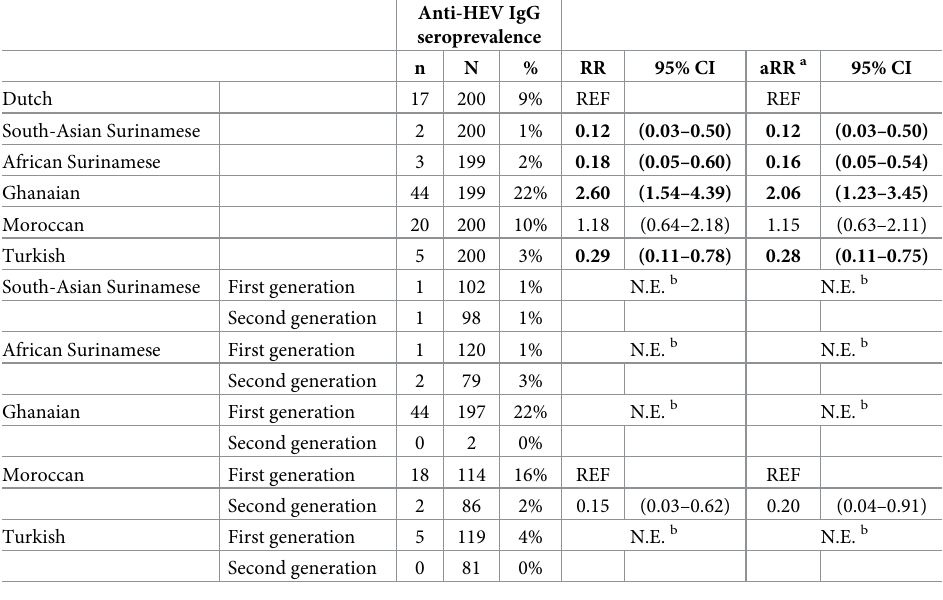
Table 2. Anti-HEV immunoglobulin G (IgG) seroprevalence by migration status among participants with differ- ent ethnic backgrounds (i.e. of South-Asian Surinamese, African Surinamese, Ghanaian, Moroccan, Turkish, or Dutch